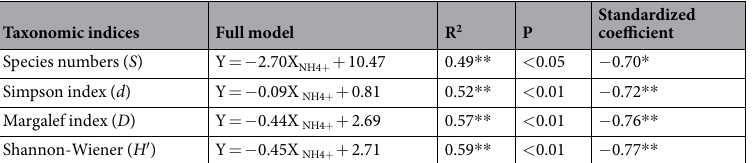
Table 4. Forward stepwise regression analyses between dependent variables (Y) of S , D , d , and H ′ and independent variables of the unique included environmental factors of NH 4 + -N. Standardized coefficient from this multiple regression analyses represents the effect intensity of the included the environmental factors on dependent variables such as S , D , d , and H ′ in the full model ( * p < 0.05; ** p < 0.01).